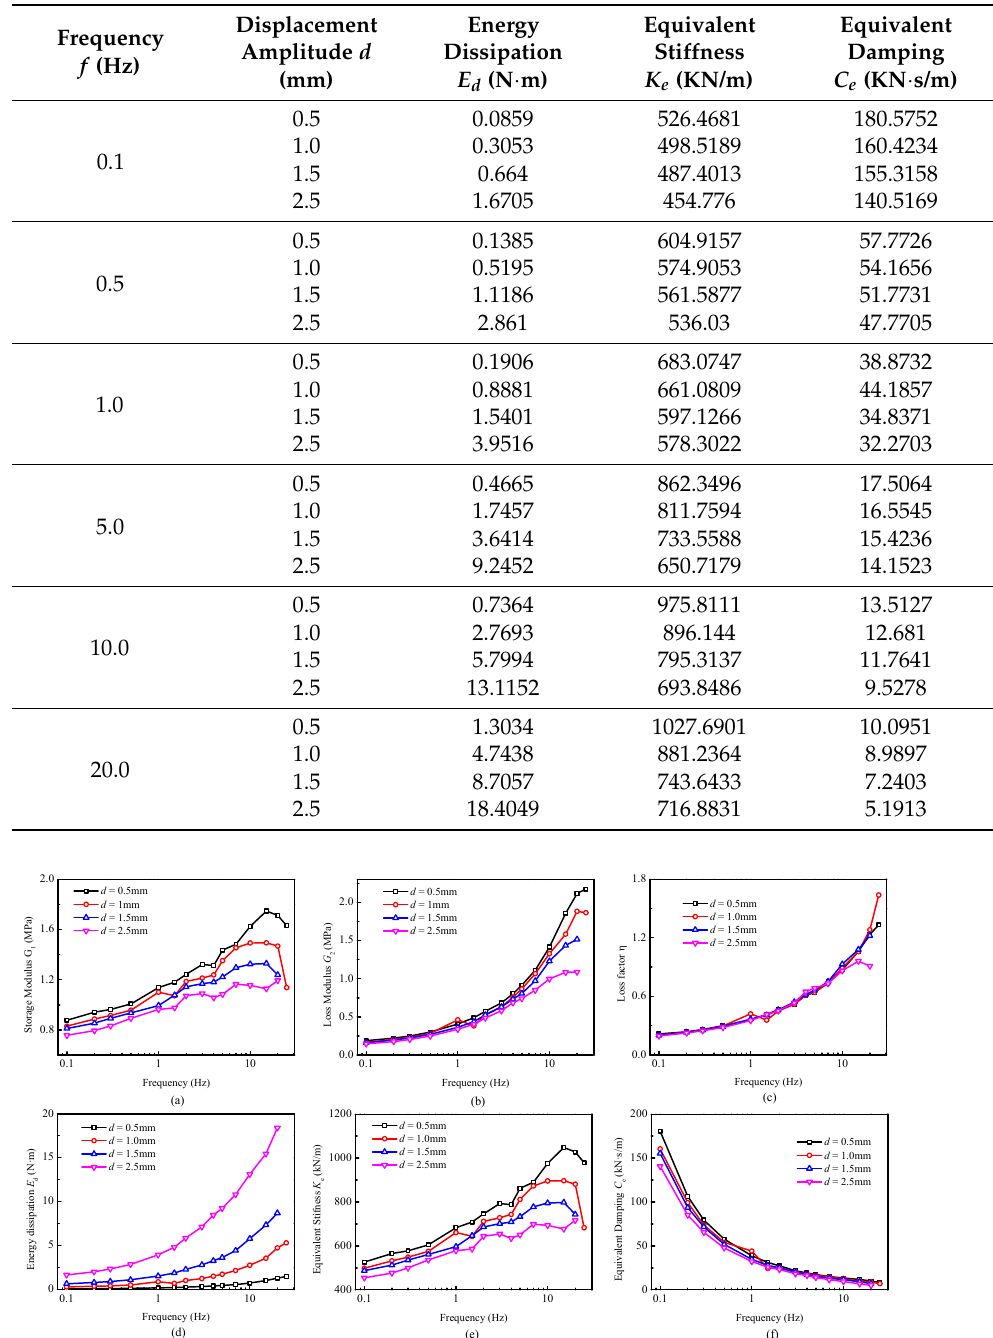
Figure 5. Dynamic properties parameters with varying frequencies. ( a ) Storage modulus. ( b ) Loss modulus. ( c ) Loss factor. ( d ) Energy dissipation. ( e ) Equivalent stiffness. ( f ) Equivalent damping.